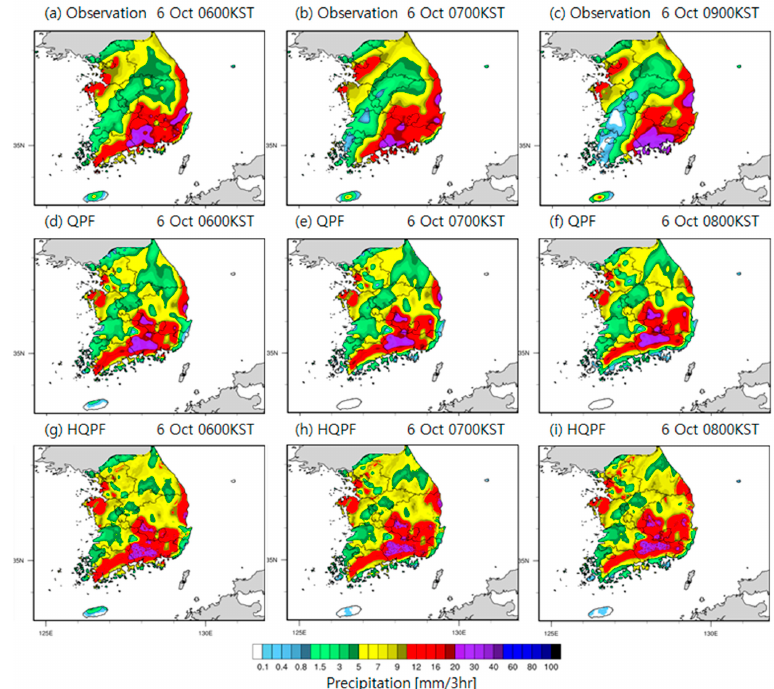
Figure 11. Spatial distribution of a 3 h accumulated rainfall for observation ( upper ), QPF ( middle ), and HQPF ( lower ) at 6:00 ( a , d , g ), 7:00 ( b , e , h ), and 8:00 ( c , f , i ) on 6 October.